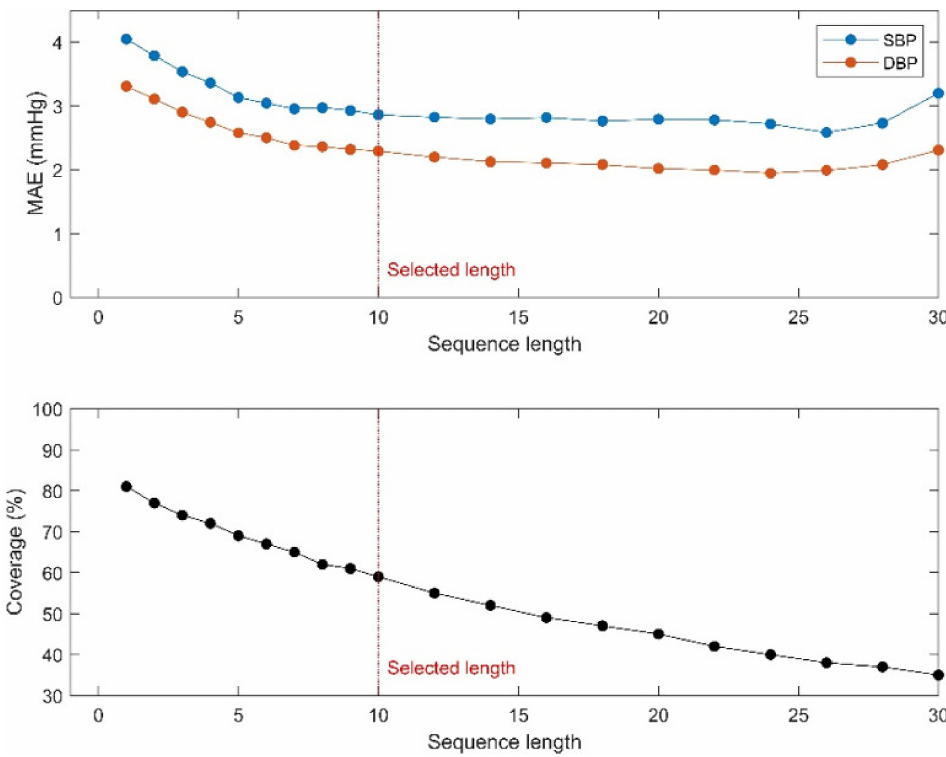
Figure 8. MAE values and coverage with different sequence lengths.